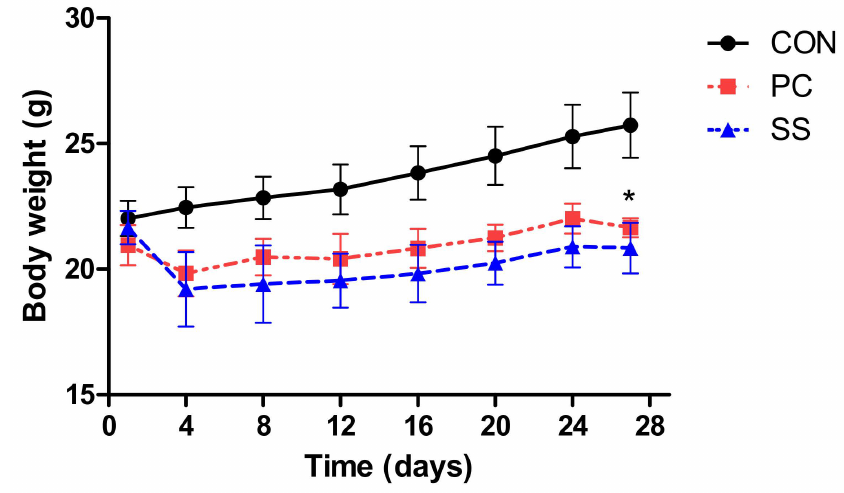
Figure 1. The body weight curves of each group. The body weight curves of positive control (PC) and test (SS) were likely to be decreased compared to control group (CON). ( n = 5, *, p <